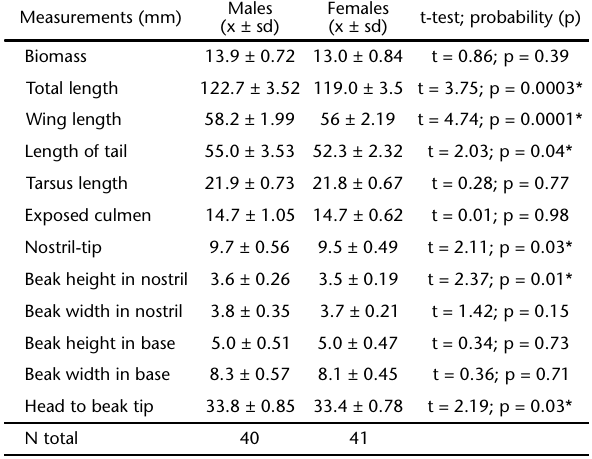
Table I. Mean (x), standard deviation (sd), t-test result, and corresponding probabilities of morphometric measurements (mm) and biomass (g) of Formicivora littoralis males and